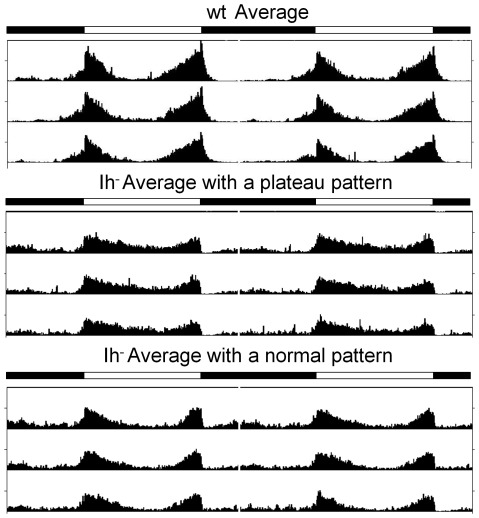

DmIh mutant flies lose the characteristic bimodal activity pattern in LD.Average actograms show the typical bimodal pattern of activity in LD in most of the control flies (98.4%, n = 53; top) and in 58.9% of the DmIh mutant flies (average of 33 flies; bottom “Ih− Average with a normal pattern”). However, the rest of the DmIh mutant flies (41.1%, n = 23) display an altered pattern characterized by a plateau of sustained activity during the light period (middle “Ih− Average with a plateau pattern”). Mutant flies also show a (plateau of?) sustained activity during the night.